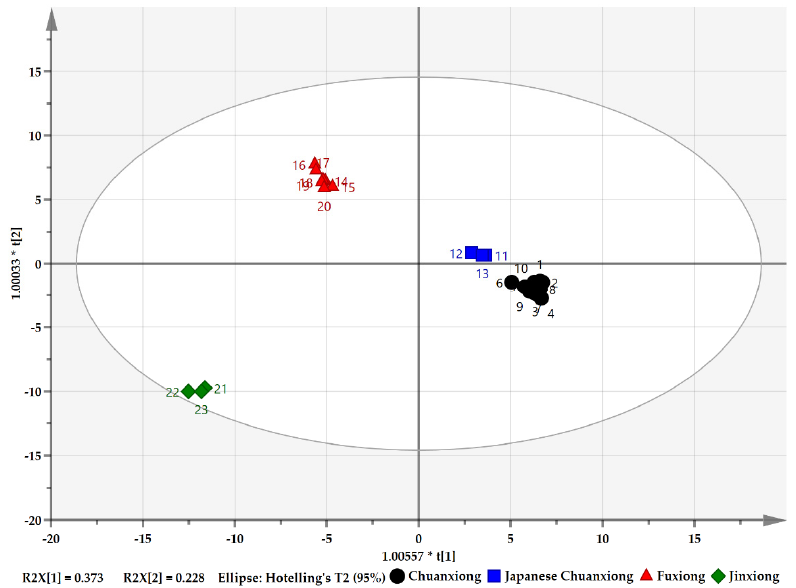
Figure 2. The plot of orthogonal partial least–squares discrimination analysis (OPLS-DA). 1–10: